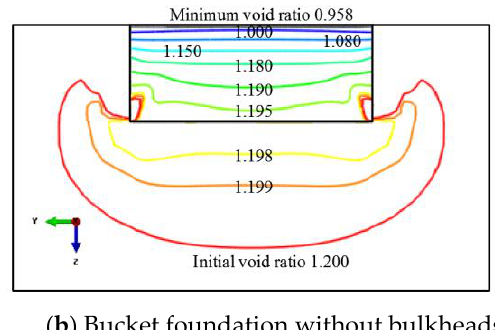
Figure 10. Void ratio contour maps of the reinforced soil.